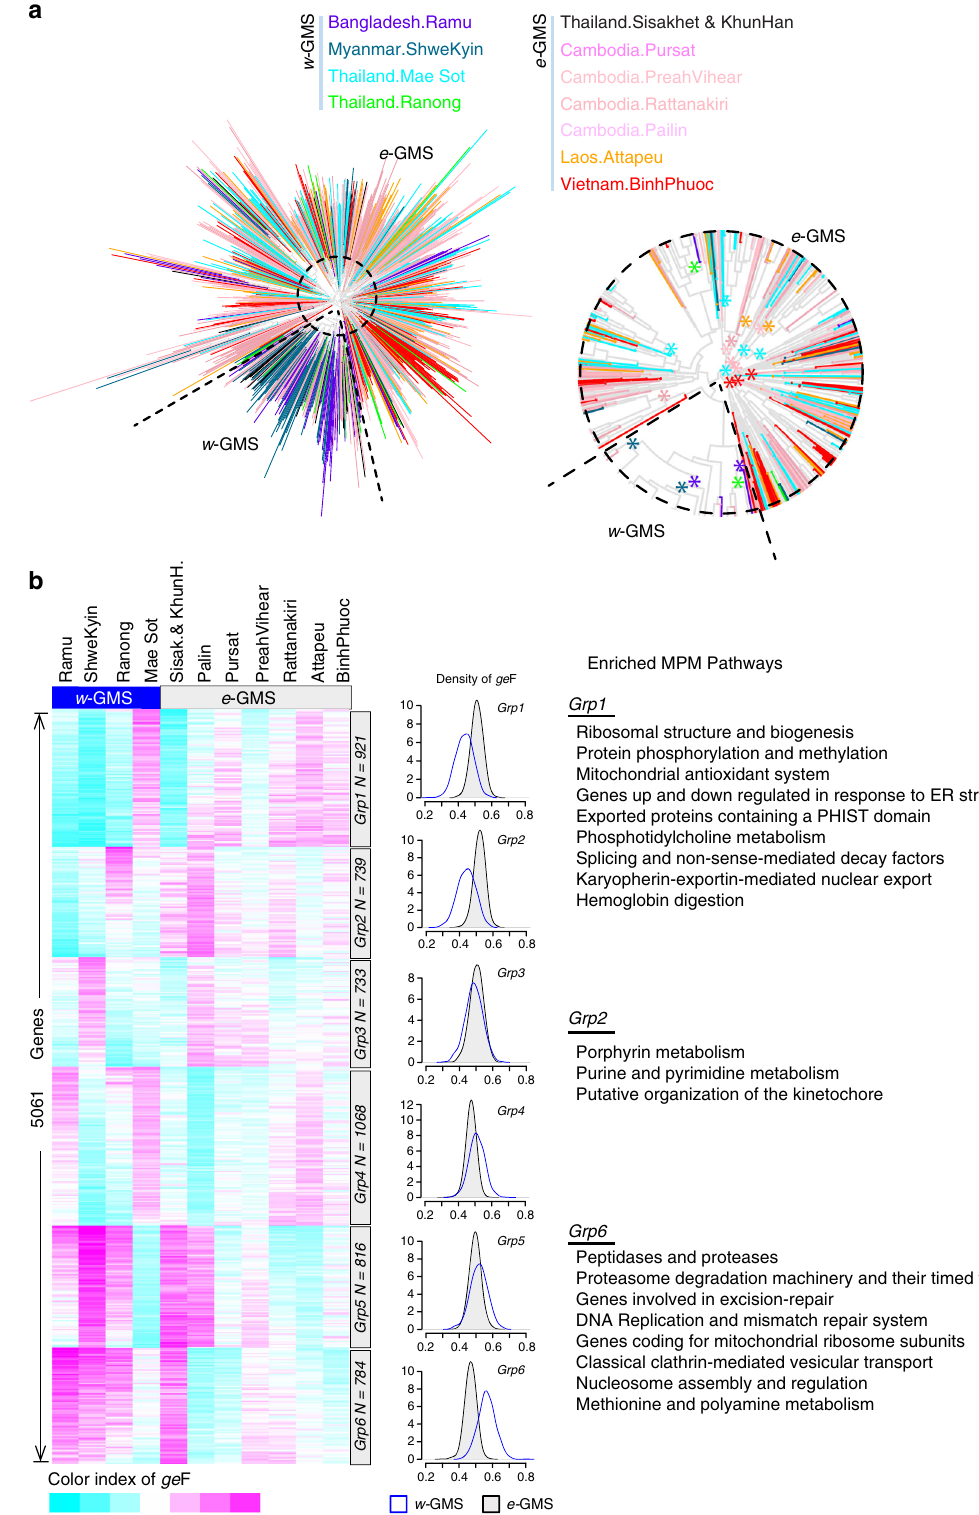
360 local linkages (7%), which linked 344 SNPs (local eQTLs) to transcriptional variations of 171 genes. Among the local eQTLs, 134 fell into the adjacent intergenic regions, from which 77 were located directly within the potential promoters upstream to their target genes. The intergenic eQTLs were more frequently linked